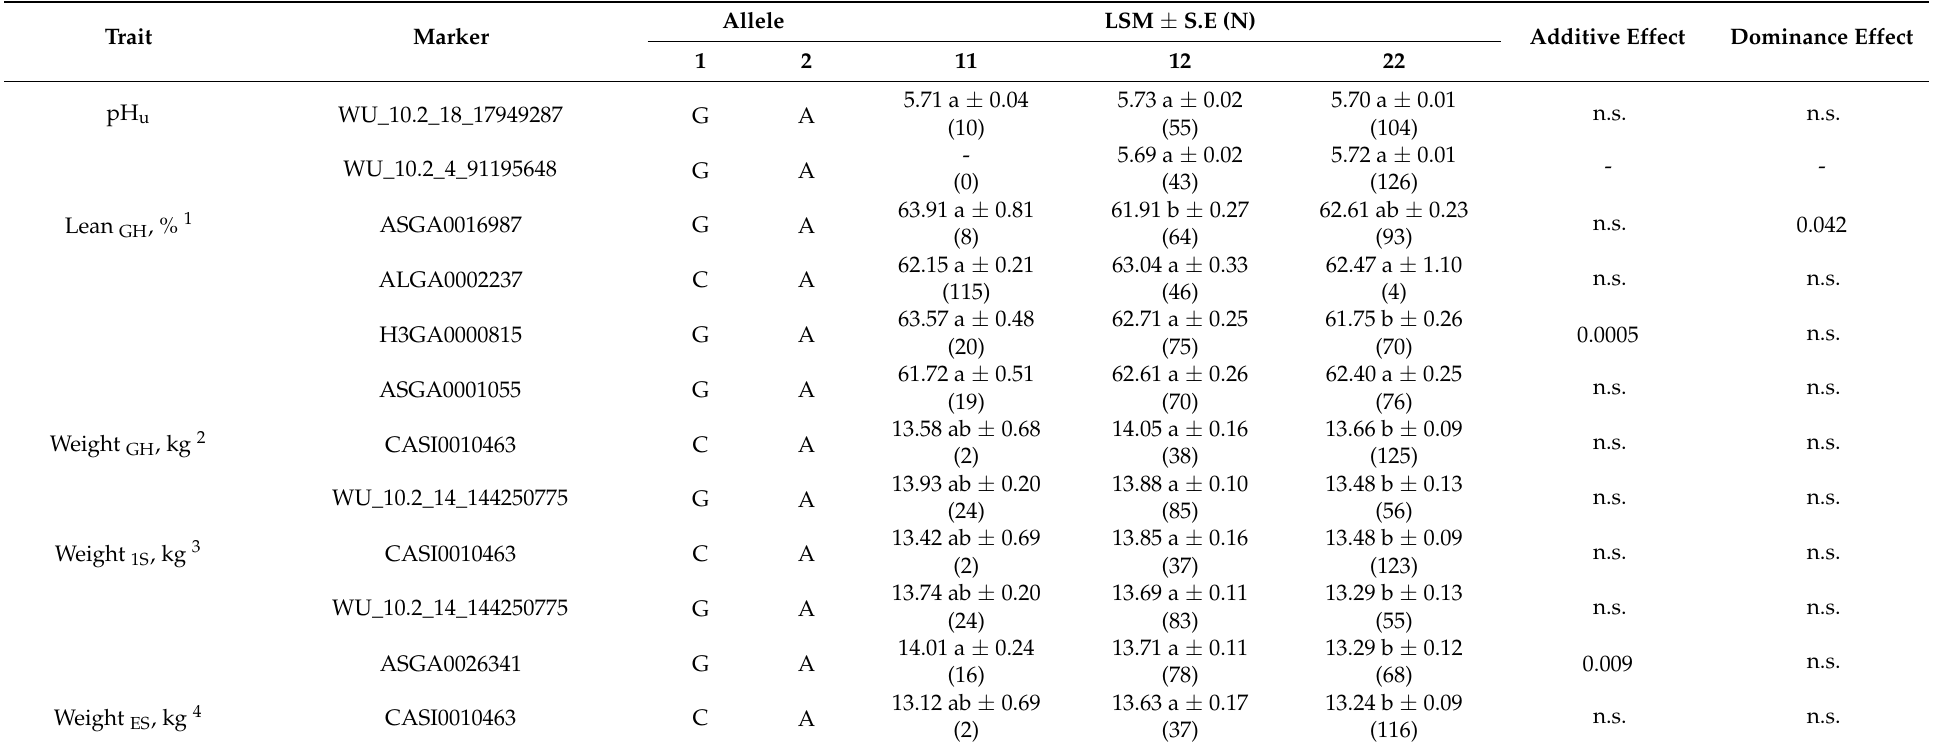
Table 3. Estimated Least Squares Means (LSM) ± standard errors (S.E.), additive and dominance genetic effects of the markers associated with ham traits. Between brackets are reported the numbers of the observations used for each